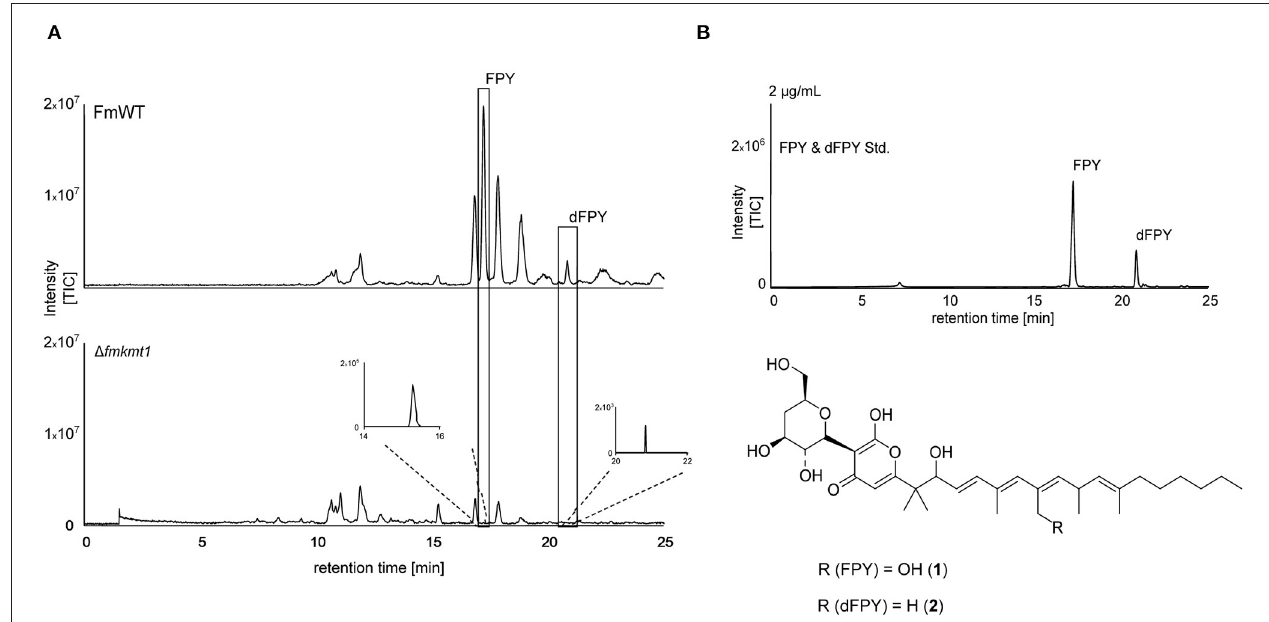
FIGURE 3 | Fusapyrone (FPY) and deoxyfusapyrone (dFPY) chemical profiles in F. mangiferae . (A) HPLC-HRMS chromatograms of FPY (1) and dFPY (2) production in the FmKMT1 deletion strain ( 1 fmkmt1 ) compared to the wild-type strain (FmWT). For this, FmWT and three independent 1 fmkmt1 strains were cultivated in FPY-inducing media for 7 days at 30 ◦ C. Experiments were performed in triplicates. The measurement of fungal supernatants show that only traces of FPY and dFPY are produced by 1 fmkmt1 compared to FmWT. (B) HPLC-HRMS chromatogram of FPY and dFPY standards (applied in a concentration of 2 µ g/mL). Structures of the γ -pyrones FPY and dFPY are shown below. TIC chromatograms (positive ESI-mode) range from m/z 100 to 1,000.